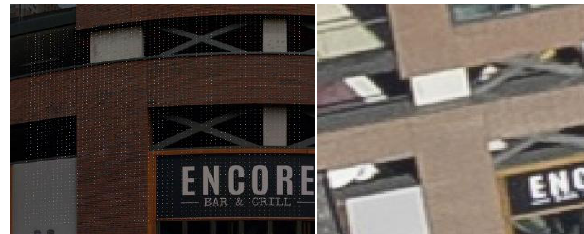
Figure 7. Original image projections of MM [left] and aerial oblique image [right]. Please note the grey dots in the left hand image - these are projected grid cells used for the extraction of image information